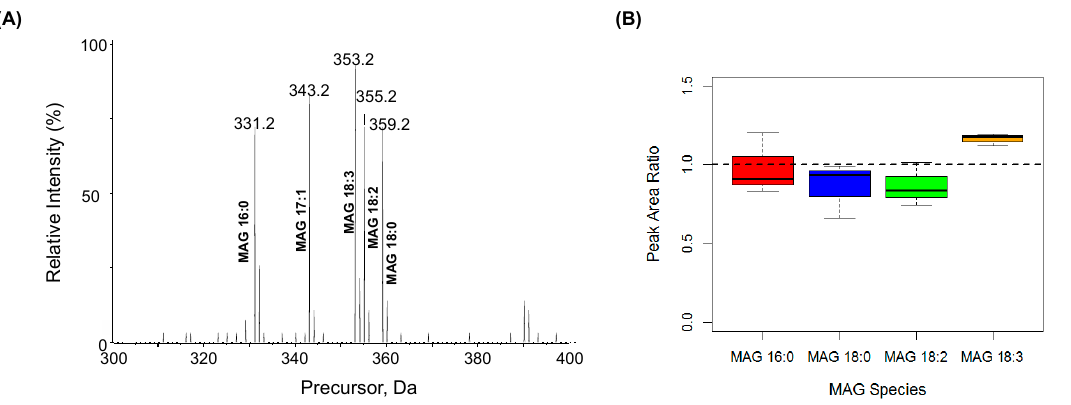
Figure 8. The plot of ESI-MS/MS response of MAG vs. the concentration of infused MAG 17:1 yielded a linear line (R 2 = 0.9993) when spiked in human plasma. The insert table shows the related quantitative parameters. LLOQ, the lower limit of quantification. The full high-resolution MS and MS/MS data were collected using the MS/MS ALL mode under the following conditions: GS1 = 10, GS2 = 10, CUR = 15, Temp = 300 °C, DP = 100 V, CE = 15 V ± 10 V.